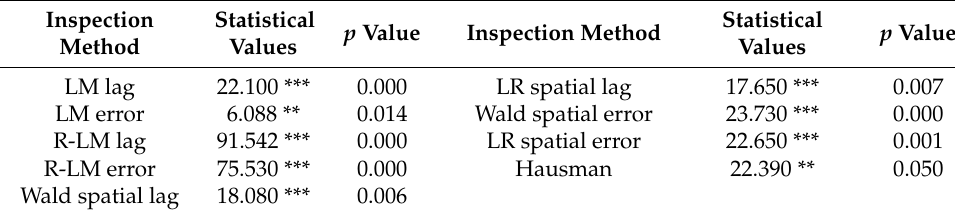
Table 4. Spatial econometric model correlation test results.